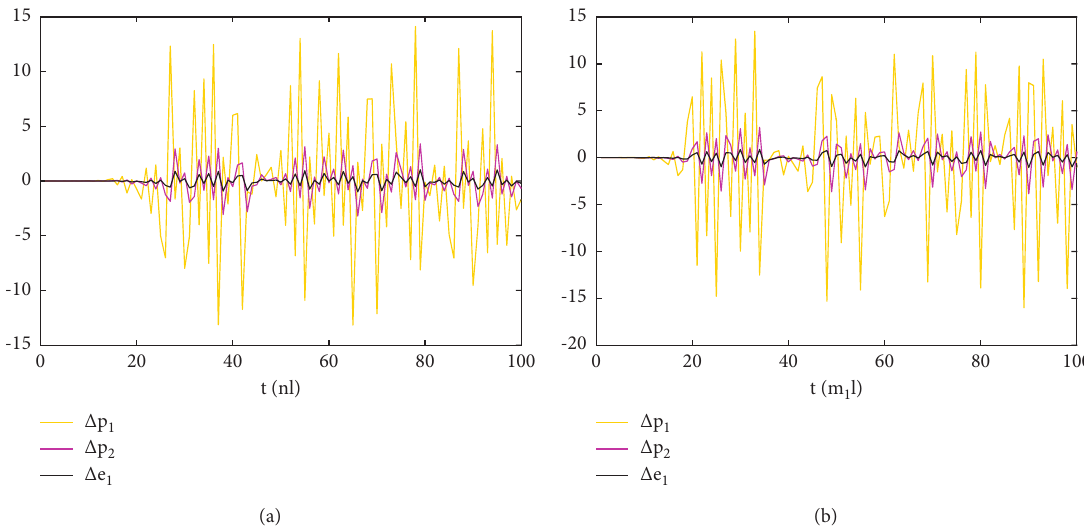
Figure 13: The sensitivity to initial value when ( p � 0 . 104. u 1